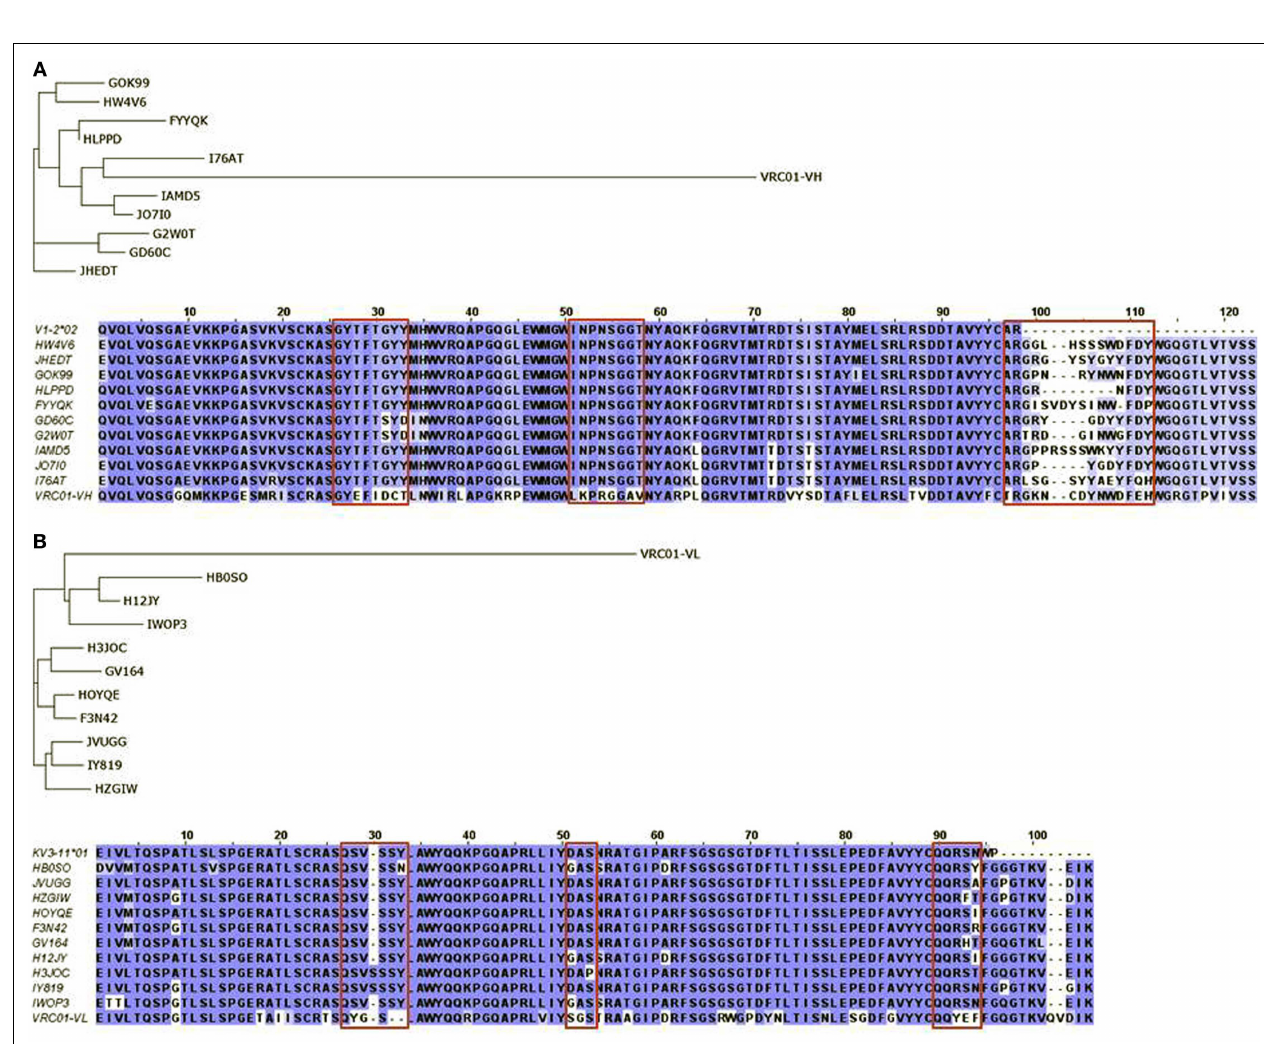
light chains ofVRC01 are shown. Multiple sequence alignments of heavy and light chain sequences along with their corresponding germline sequences,V1-2*02 and KV3-11*01, made using BLOSUM62 scoring matrices, conserved substitution (blue) and non-conserved substitution (white) are